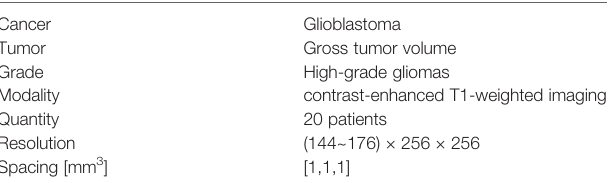
TABLE 1 | Characteristics of MRI.